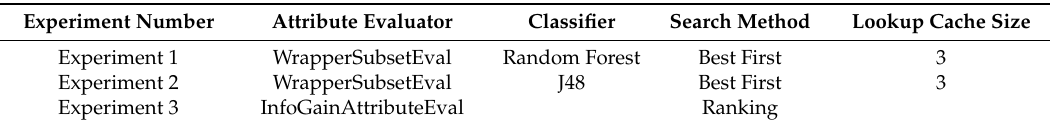
Table 6. Three classification algorithms for the second type of analysis.